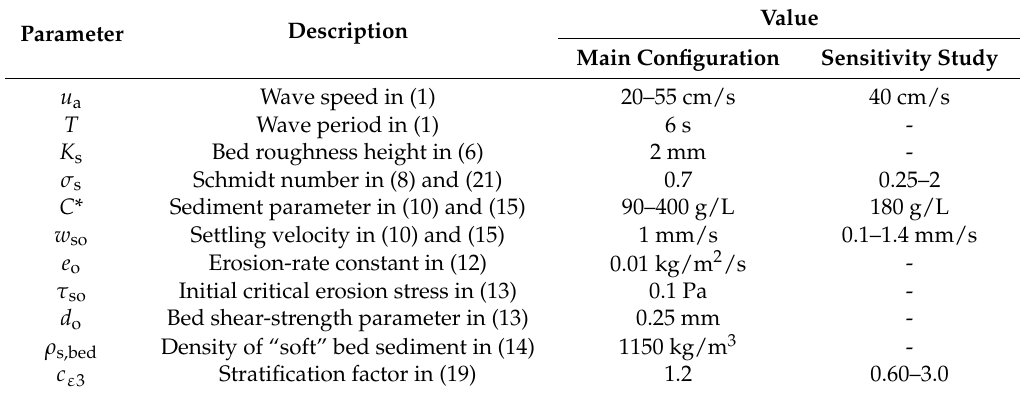
Table 1. Key parameters and values.